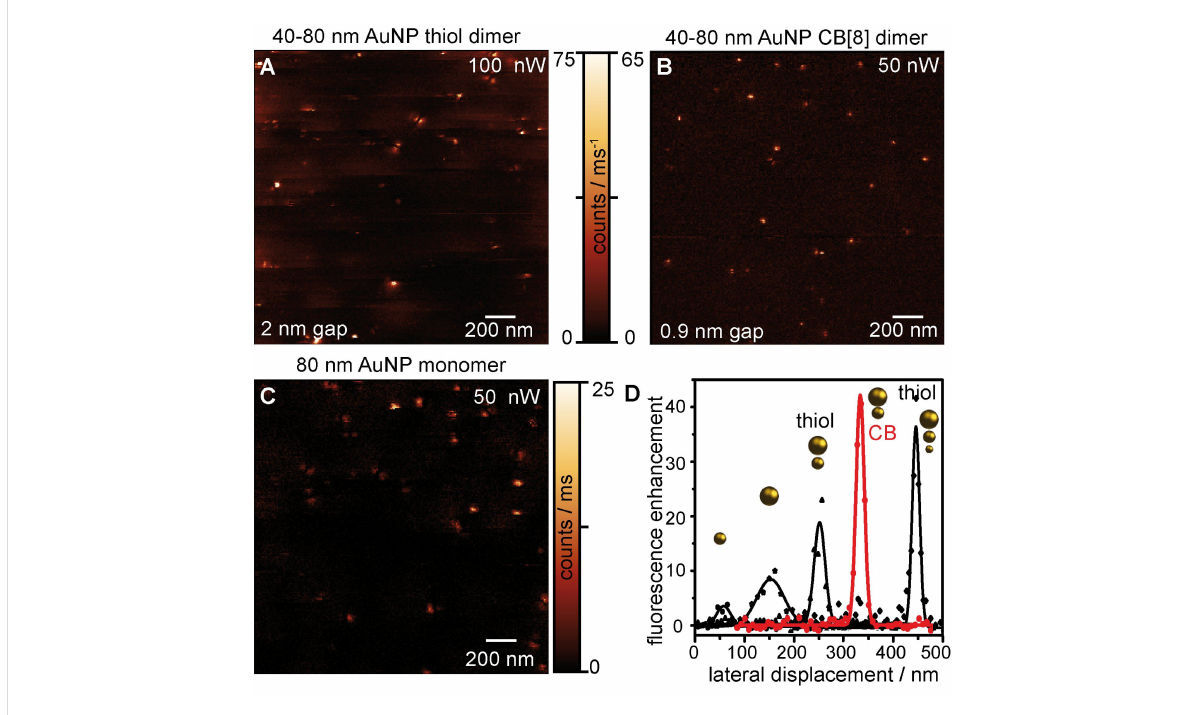
Figure 2: Antenna-enhanced fluorescence images of randomly distributed high-QY emitters on a glass surface imaged with dimer antennas with a gap size of 1.5 nm (A) and 1 nm (B), and a monomer antenna (C). (D) Line profiles taken from individual monomer- (40 nm and 80 nm AuNP), dimer- (40–80 nm thiol and CB[8] mediated) and trimer (20–40–80 nm thiol-mediated)-enhanced fluorescence spots normalized to the confocal background signal for comparison of the provided fluorescence enhancement and light confinement